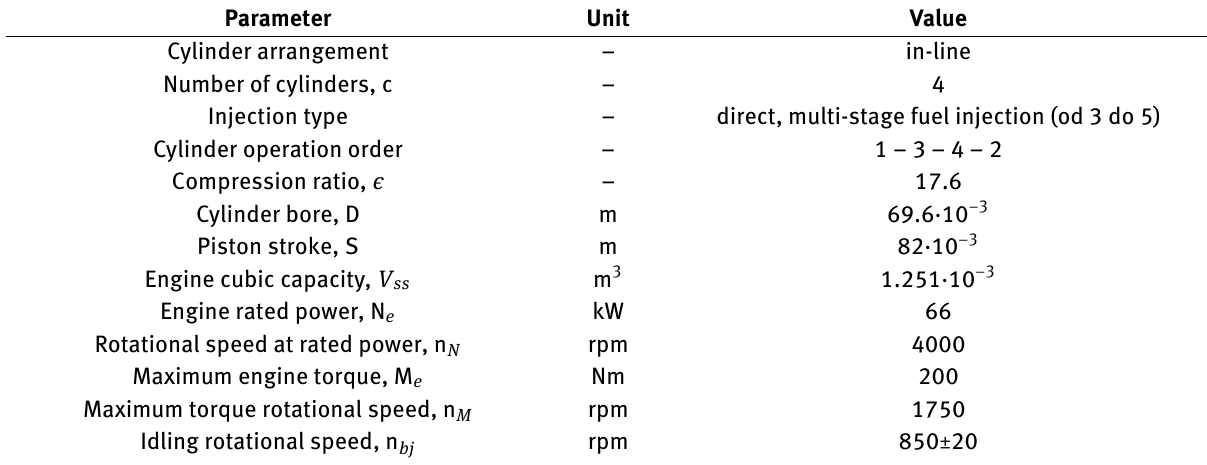
Table 1: Basic technical specification of the FIAT 1.3 Multijet SDE 90 HP